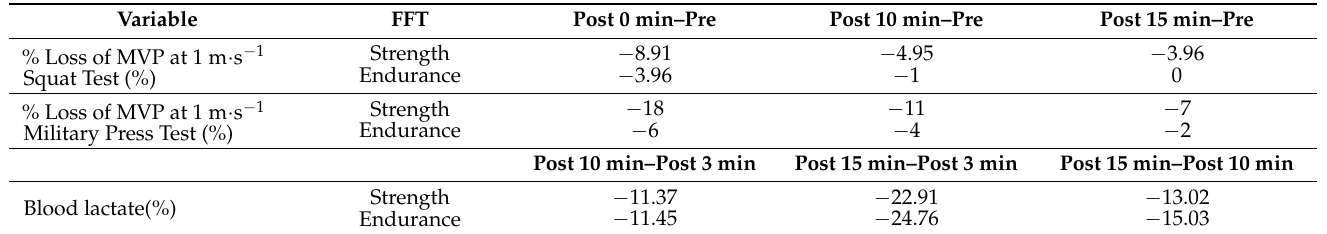
Table 3. Analysis of the variable velocity and blood lactate before and after performing the strength and endurance FFT